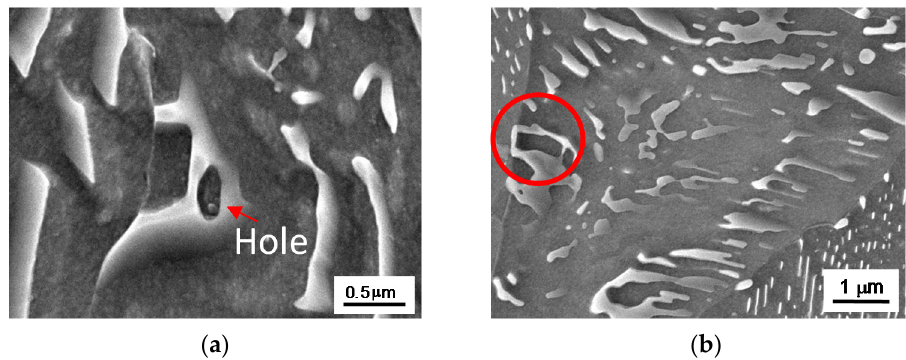
Figure 7. Micrograph showing the presence of a hole in a cementite lamella in an initial coarse pearlite microstructure ( a ). Detail of a hole growth (red circle) after the intermediate cycle causing lamellae break-up according to the migration of the edge of the hole in the coarse pearlite after the intermediate cycle ( b ).